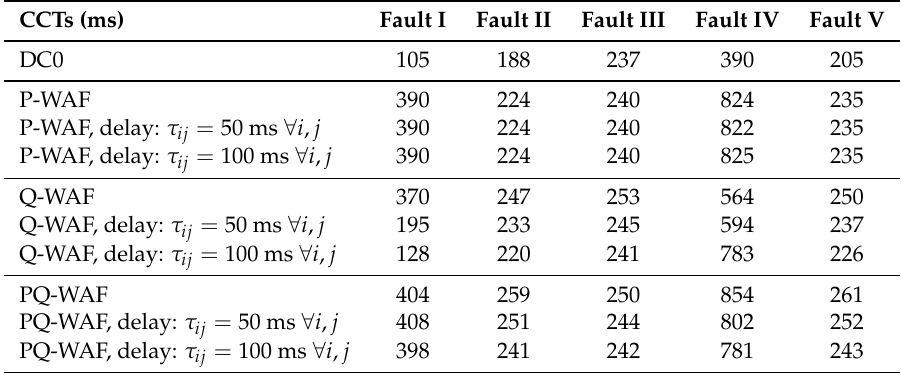
Table 12. Case B. CCT. Effect of communication latency.